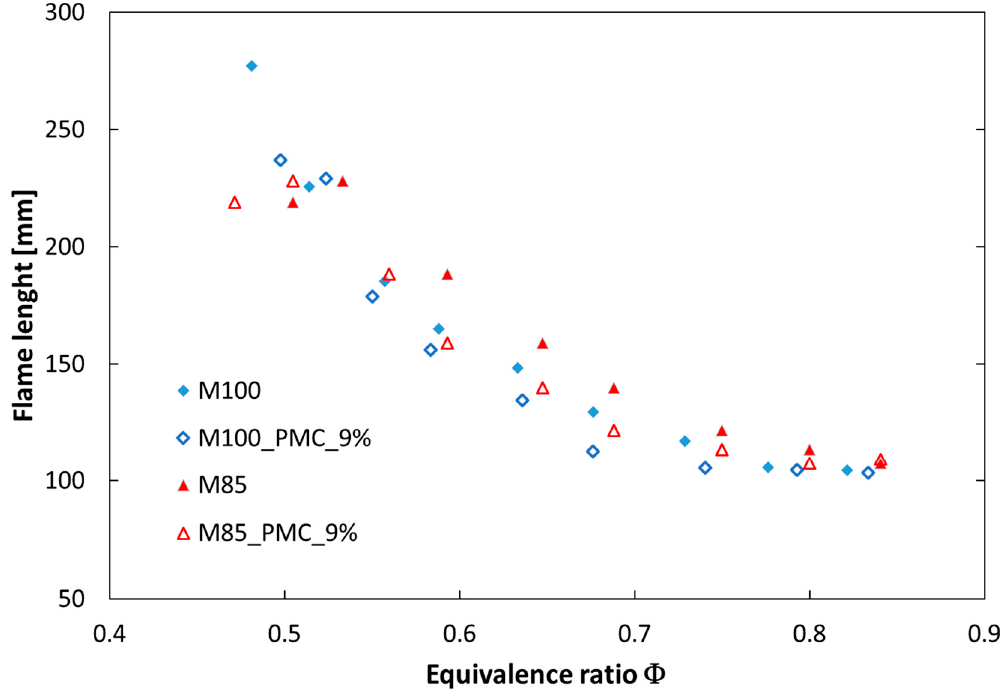
Figure 13. Flame length for the fuels M100 and M85 at elevated pressure (P = 0.25 MPa) versus equivalence ratio.